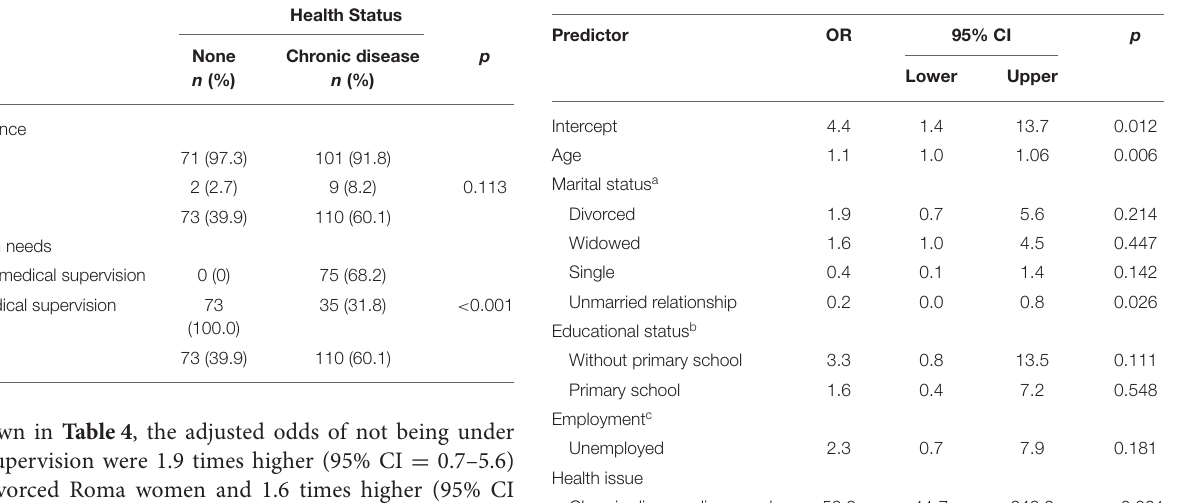
TABLE 4 | Odds ratios and associated 95% confidence intervals for adjusted multiple logistic regression of sociodemographic and health status associated with met health